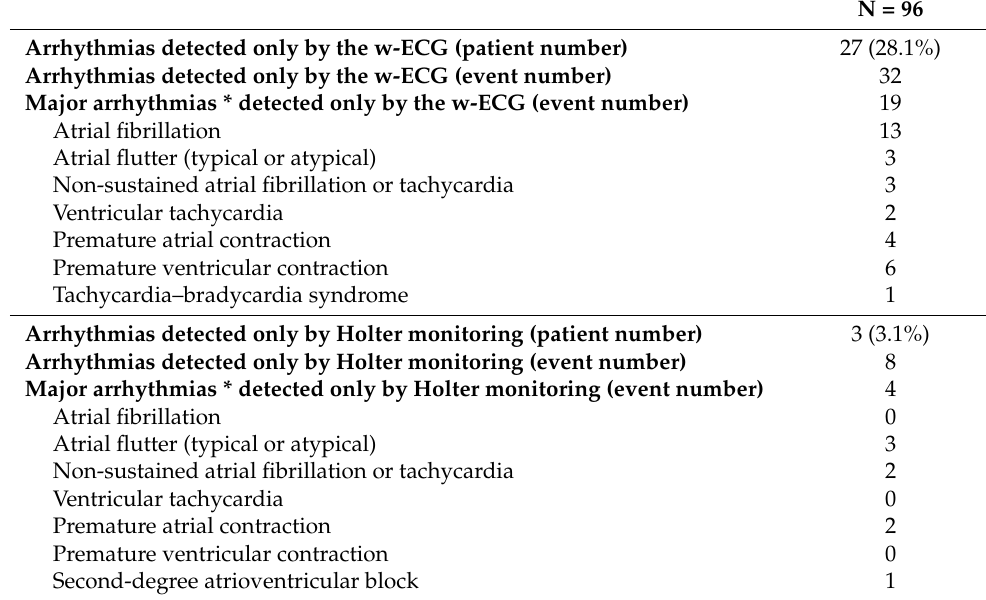
Arrhythmias detected only by the w-ECG (patient number) 27 (28.1%) Arrhythmias detected only by the w-ECG (event number) Major arrhythmias * detected only by the w-ECG (event number)